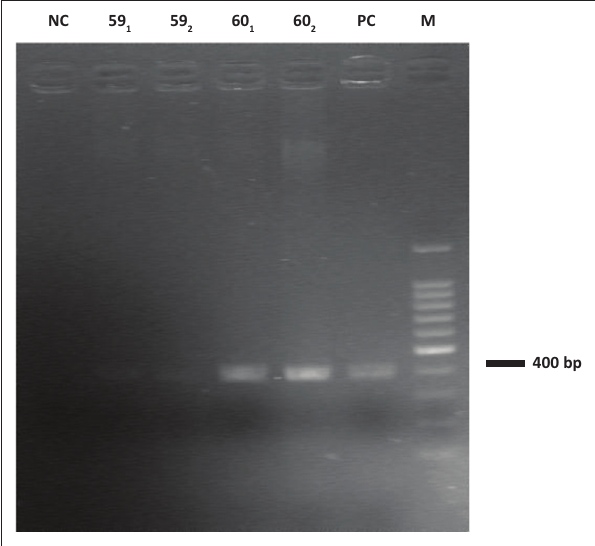
FIGURE 1: Real-time PCR amplification of patient sera and controls.